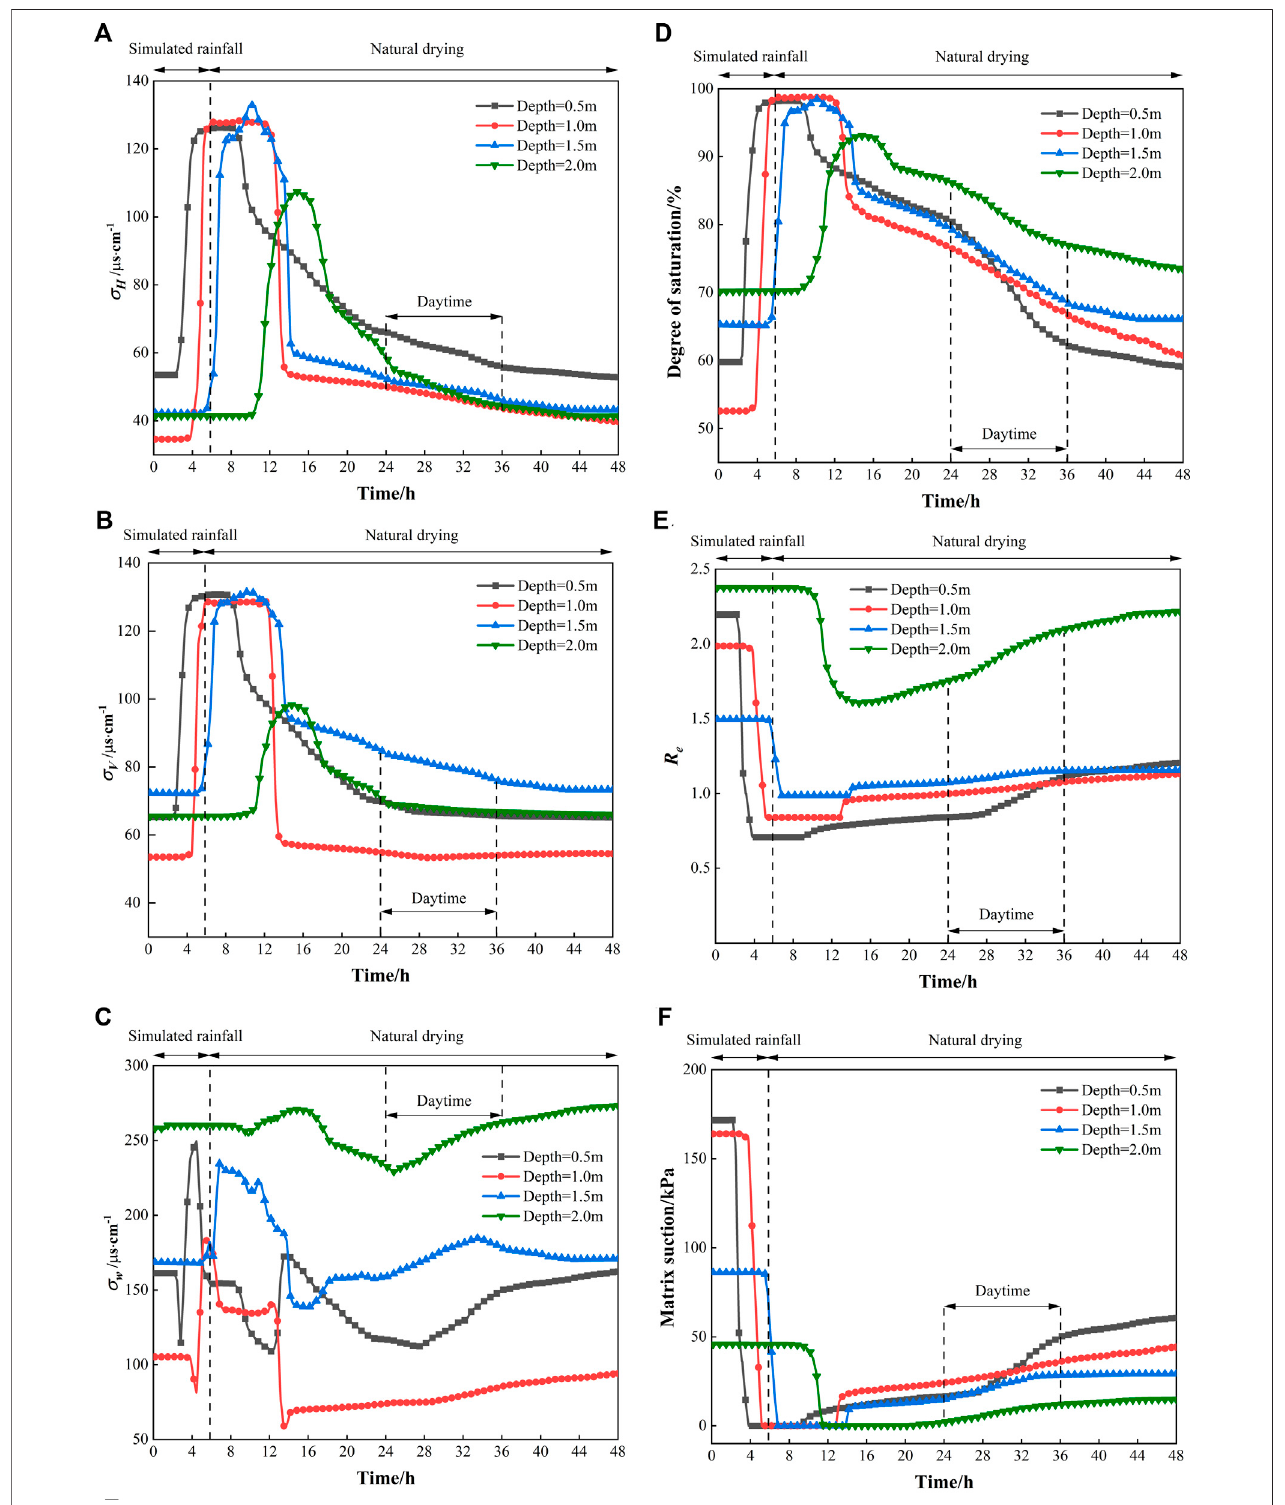
FIGURE 15 | (A) Time-history curve of the horizontal electric conductivity. (B) Time-history curve of the vertical electric conductivity. (C) Time-history curve of the conductivity of pore water. (D) Time-history curve of soil saturation. (E) Time-history curve of comprehensive structural parameters. (F) Time-history curve of matrix suction.